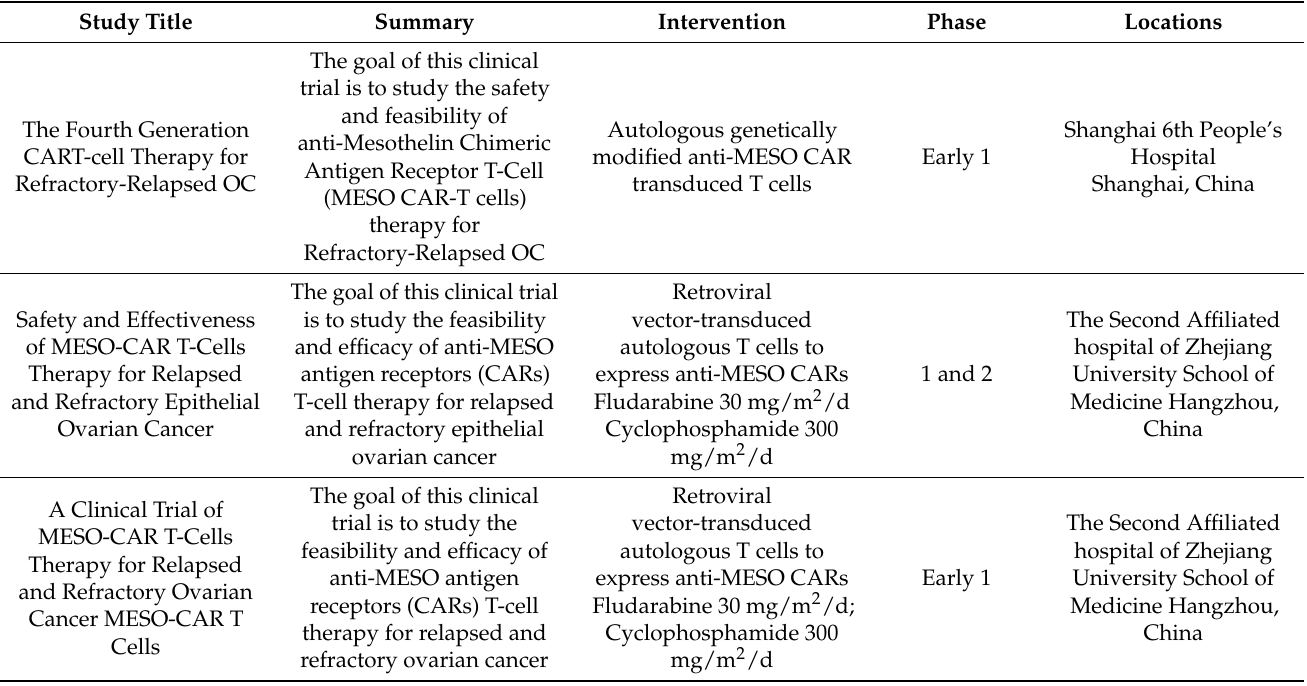
Table 3. Actually running studies including the application of CAR-T chimeric antigen receptors in solid cancer treatment, according to